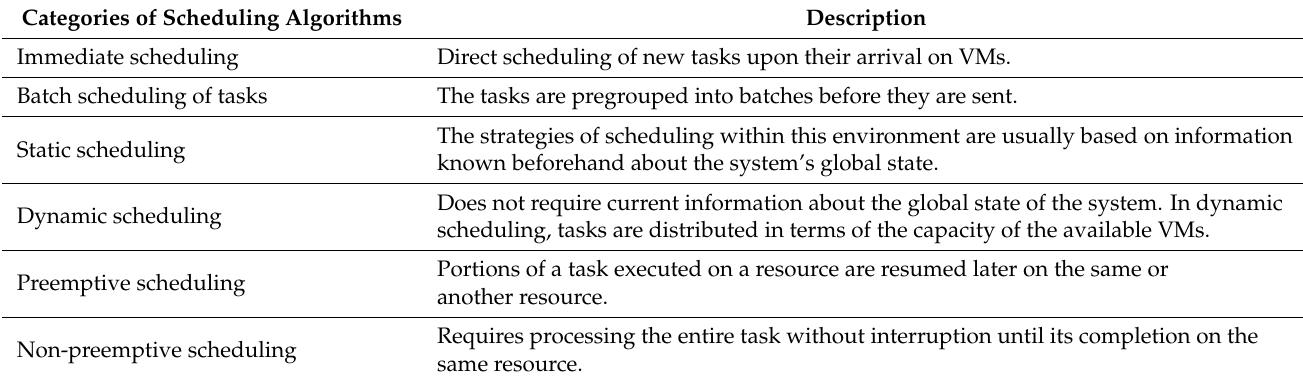
Table 1. Classification of task scheduling